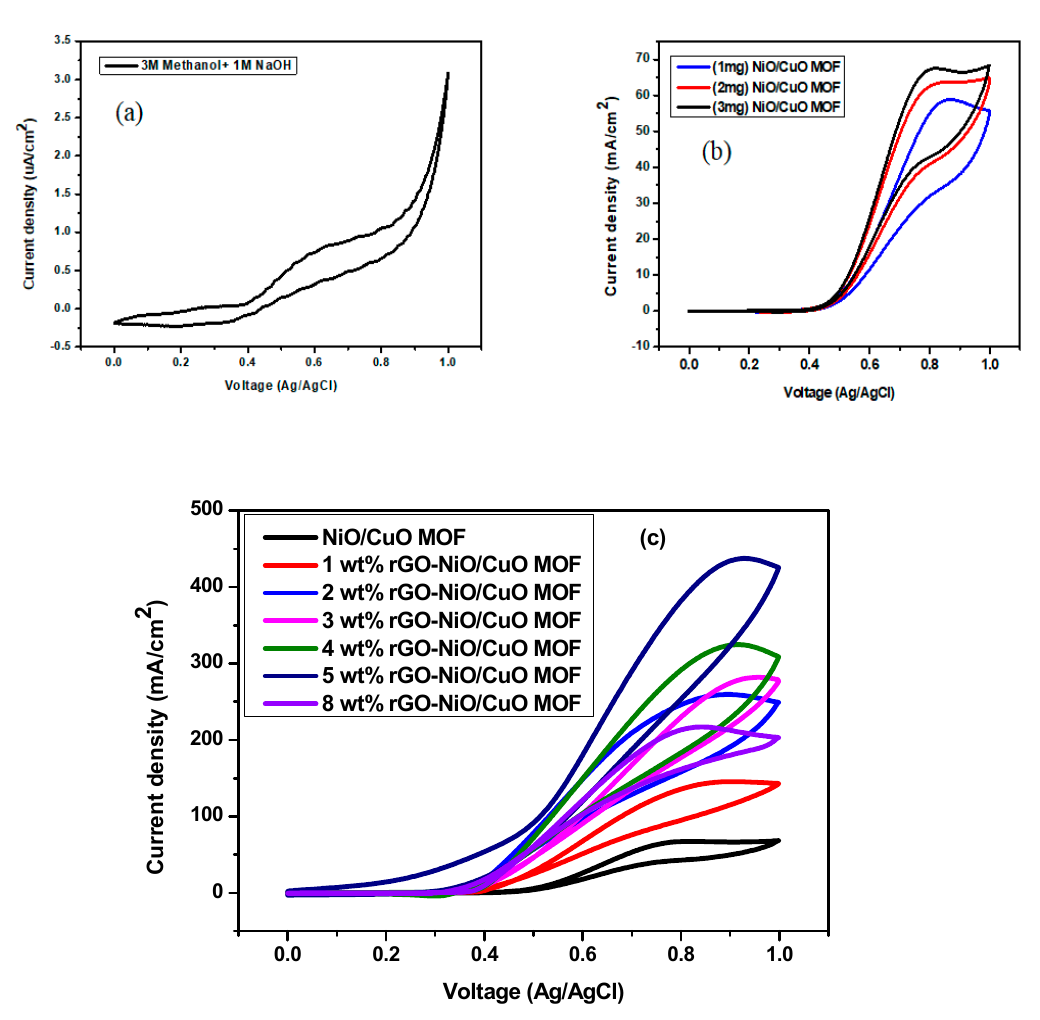
Figure 5. Cyclic Voltamograms of ( a ) bare glassy carbon electrode (GCE) ( b ) NiO / CuO MOF in di ff erent concentrations ( c ) composites with 1 wt%, 2 wt%, 3 wt%, 4 wt%, 5 wt% and 8 wt% rGO / NiO / CuO MOF in 3M CH 3 OH and 1M NaOH at 50 mV/s.